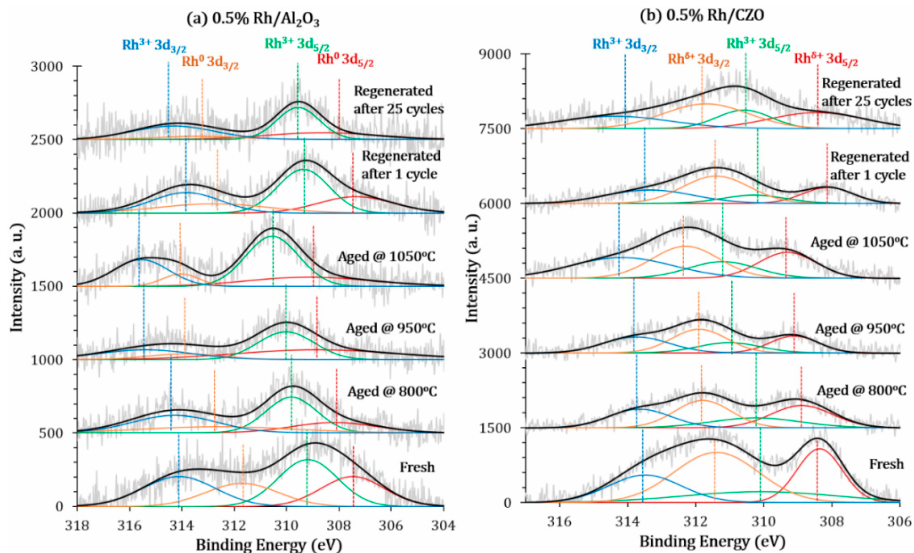
Figure 13. X-ray Photoelectron Spectroscopy (XPS) multiplex spectra in Rh 3d region (with BE of 318 eV–304 eV) of fresh, aged, and regenerated ( a ) 0.5% Rh/Al 2 O 3 and ( b ) 0.5% Rh/CZO powder catalysts, and with aging temperature varied. Aged samples were achieved by aging the fresh catalysts in air at 800 °C, 950 °C or 1050 °C for 5 min. Regenerated samples were achieved by regenerating the aged ones (1050 °C for 5 min) using the method as described in Section 3.3. Table 6. Summary of detailed information of XPS spectra as shown in Figure 12, i.e. , values of binding energy Rh 3d 3/2 for Rh 3+ and Rh 0 oxidation states, and Rh 3+ /Rh 0 (or Rh 3+ /Rh δ + ) ratios a for fresh, aged, and regenerated 0.5% Rh/Al 2 O 3 and 0.5% Rh/CZO samples.